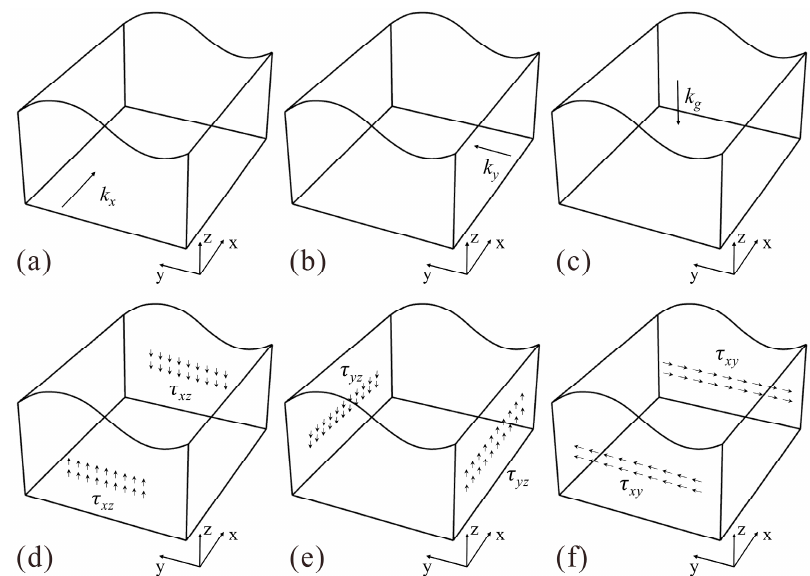
Figure 1. Different boundary conditions. ( a ) horizontal stress in the X-direction; ( b ) horizontal stress in the Y-direction; ( c ) gravity stress; ( d ) shear stress in the XZ-plane; ( e ) shear stress in the YZ-plane; and ( f ) shear stress in the XY-plane.